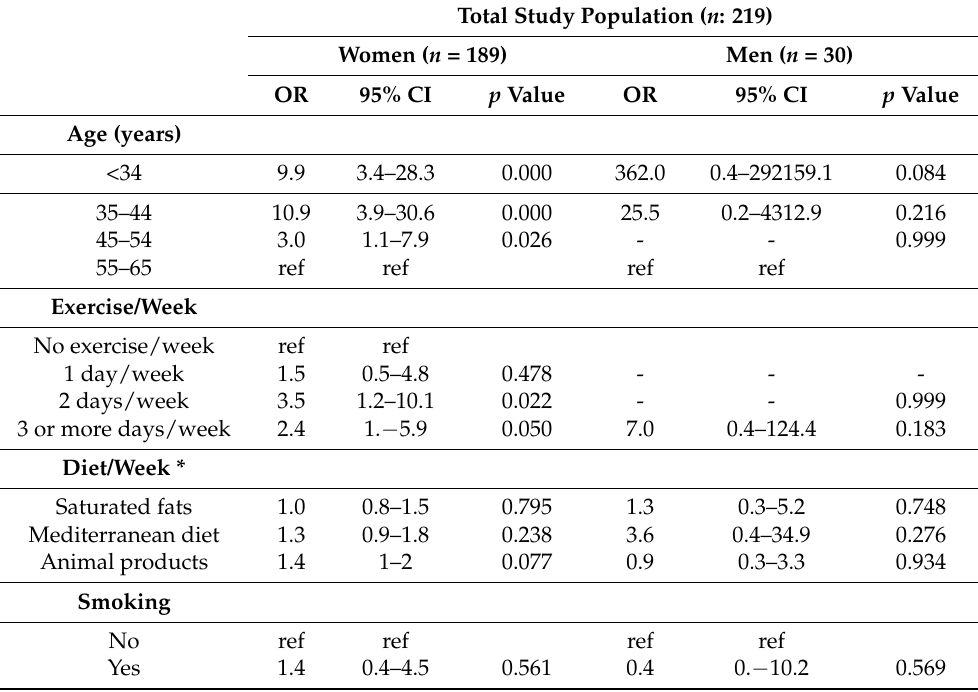
Table 5. Logistic regression considering shift work as a dependent variable stratifying by sex.